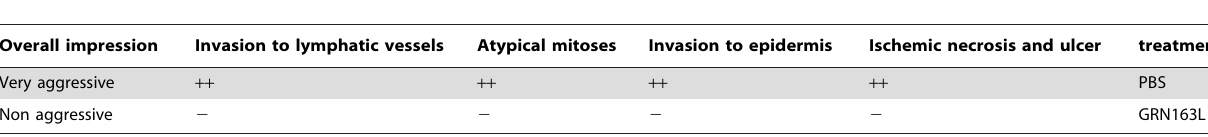
Table 3. Histological analyses of tumors with shortened